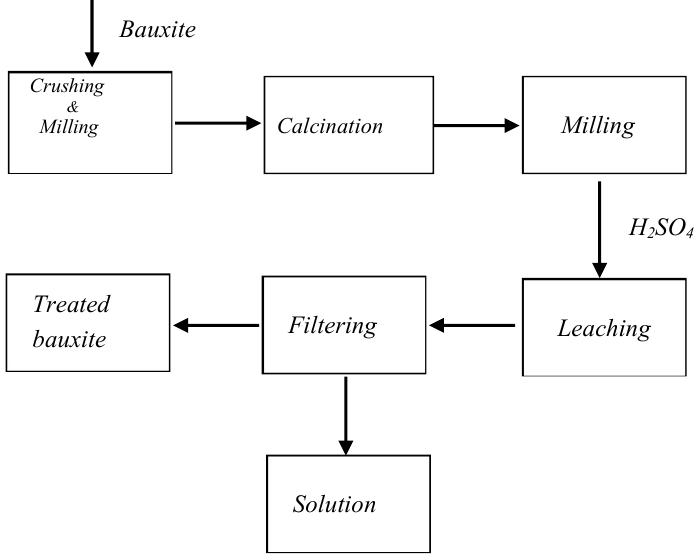
Figure 1. Schematic diagram of removing impurities from bauxite.